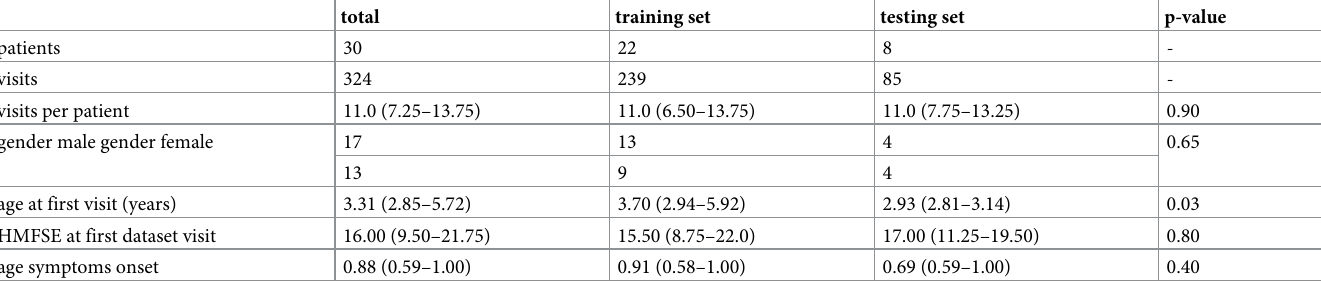
Table 1. 6-months HMFSE dataset summary. Numerical values are reported as median and interquartile range.